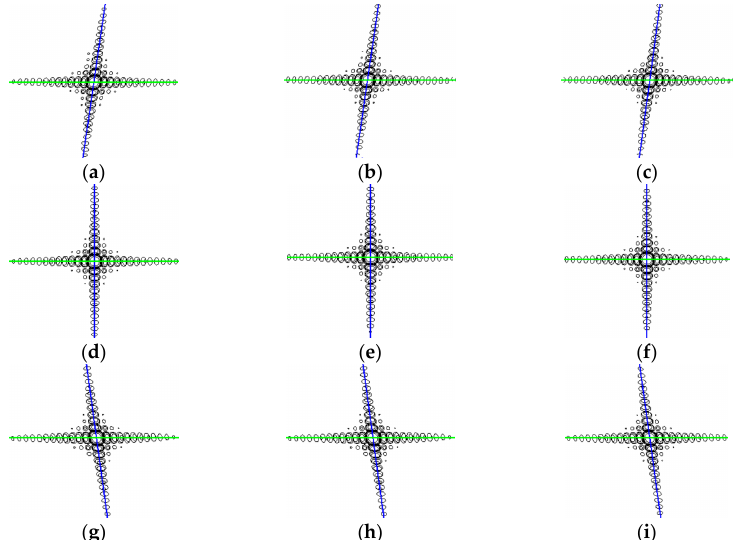
Figure 12. The interpolated contour plot of the nine point targets, with ( a – i ) corresponding to point targets from P 1 to P 9